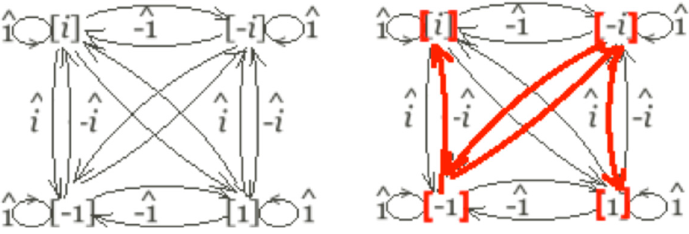
Figure 1. Determinant products for the matrices in the Chomsky group.